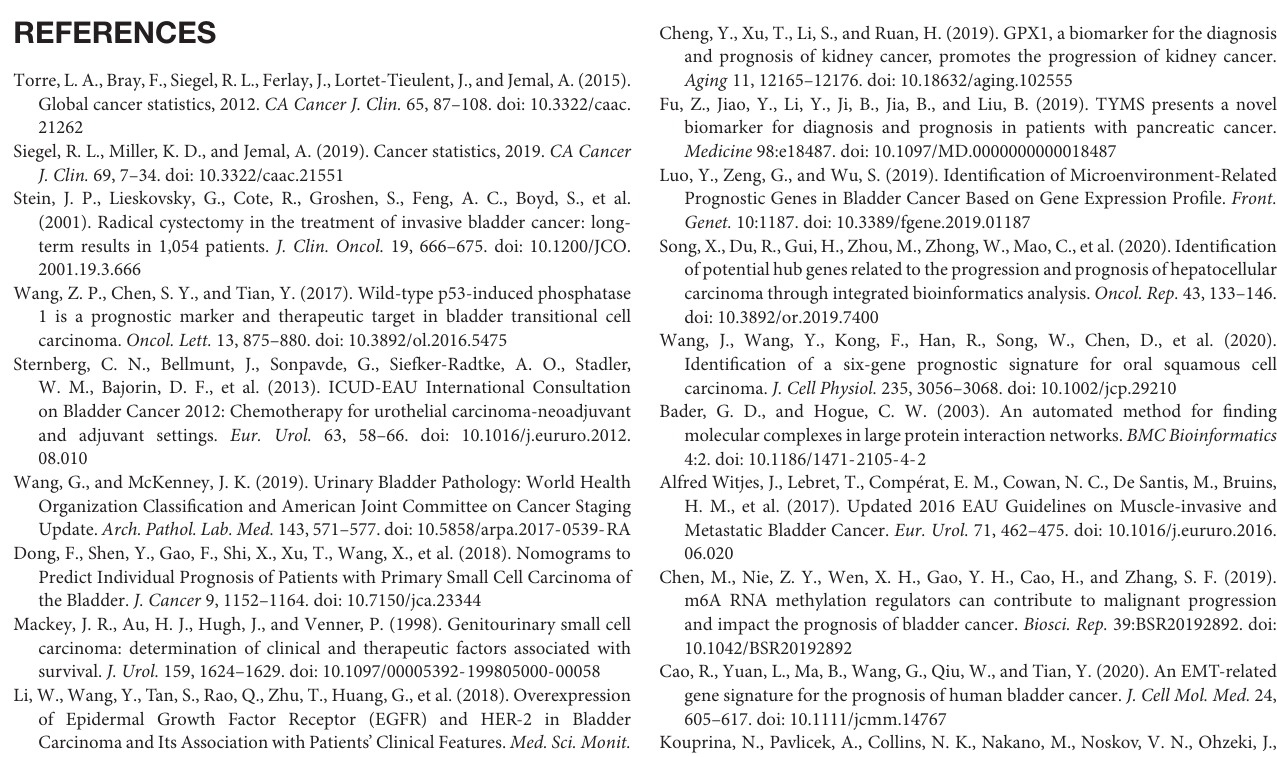
Supplementary Figure 1 | Kaplan-Meier survival analysis the for 30 hub genes. Supplementary Table 1 | Clinical data of TCGA-BLCA. Supplementary Table 2 | Hub